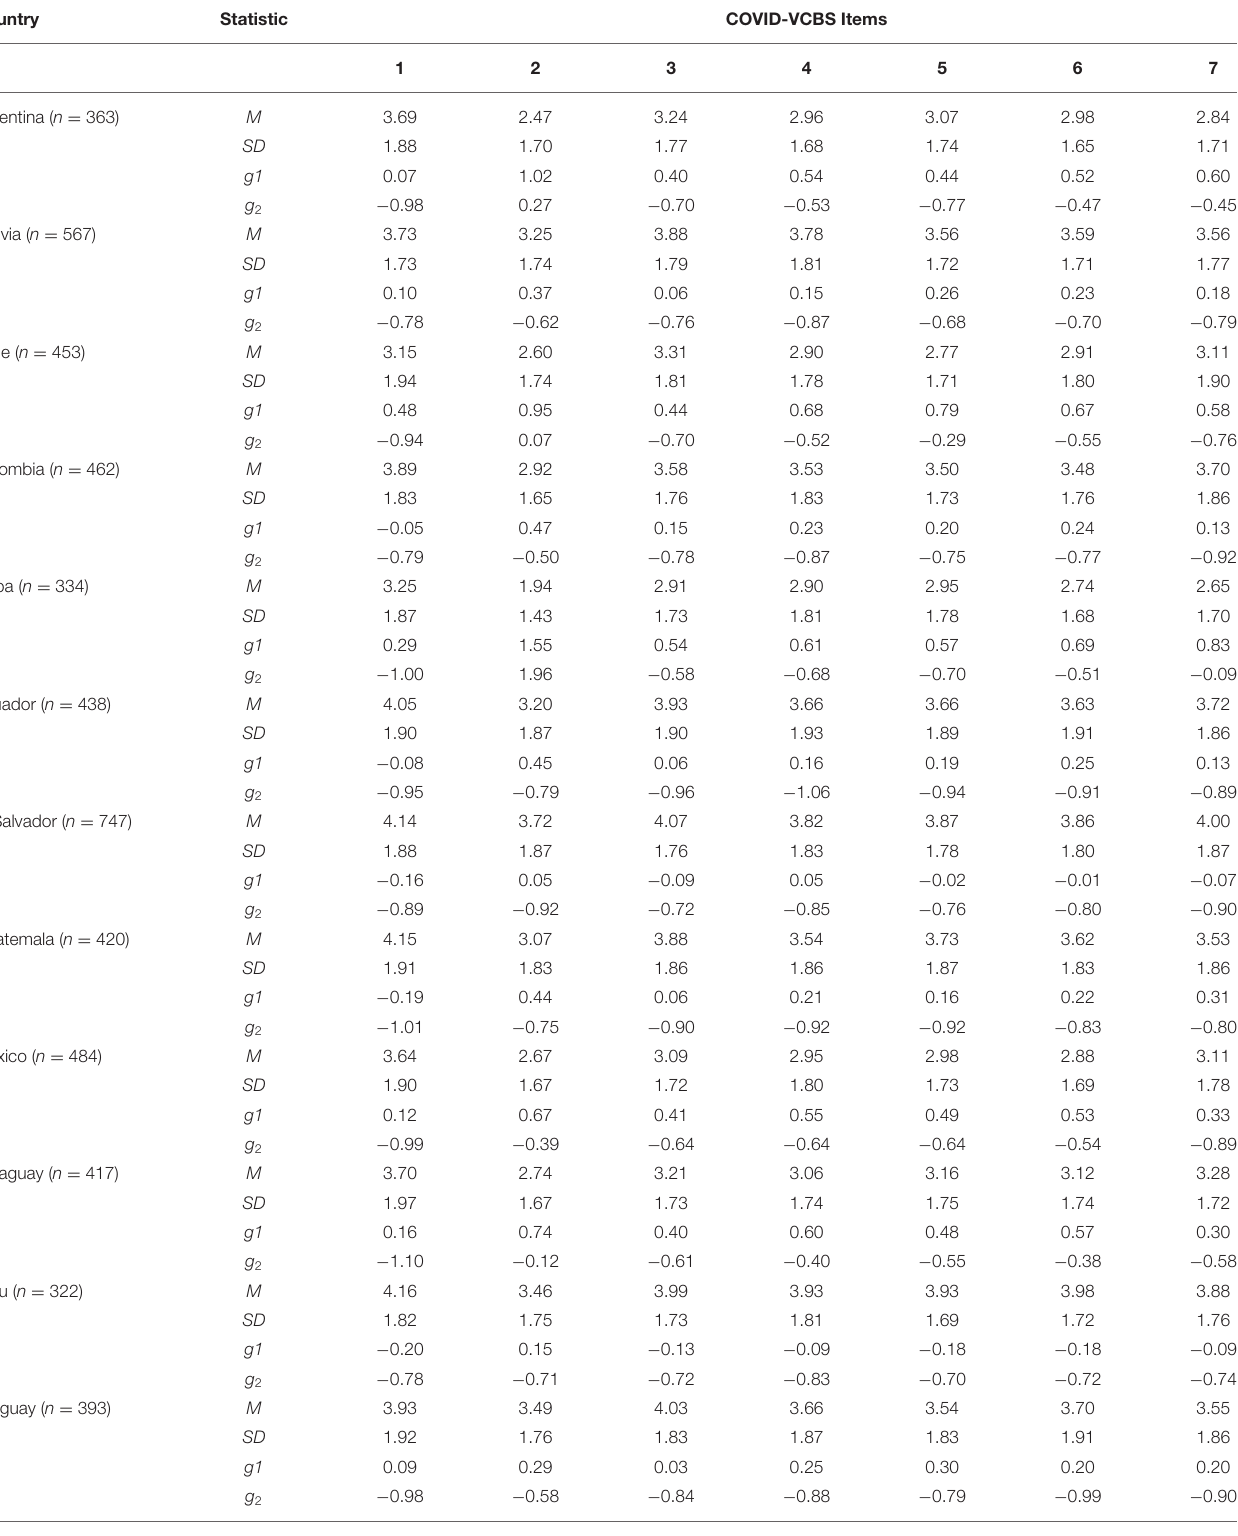
TABLE 4 | Item-level descriptive statistics of the COVID-VCBS items.